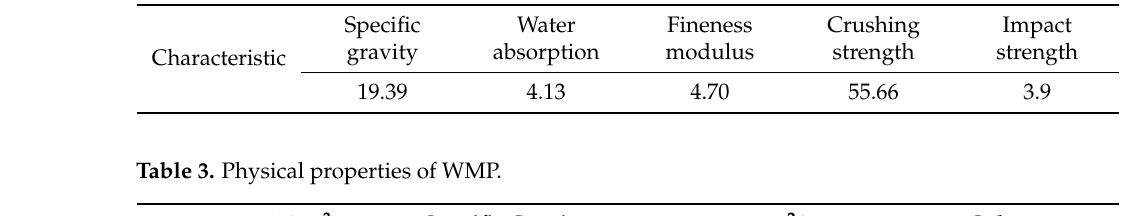
Table 2. Physical properties of coarse aggregates.